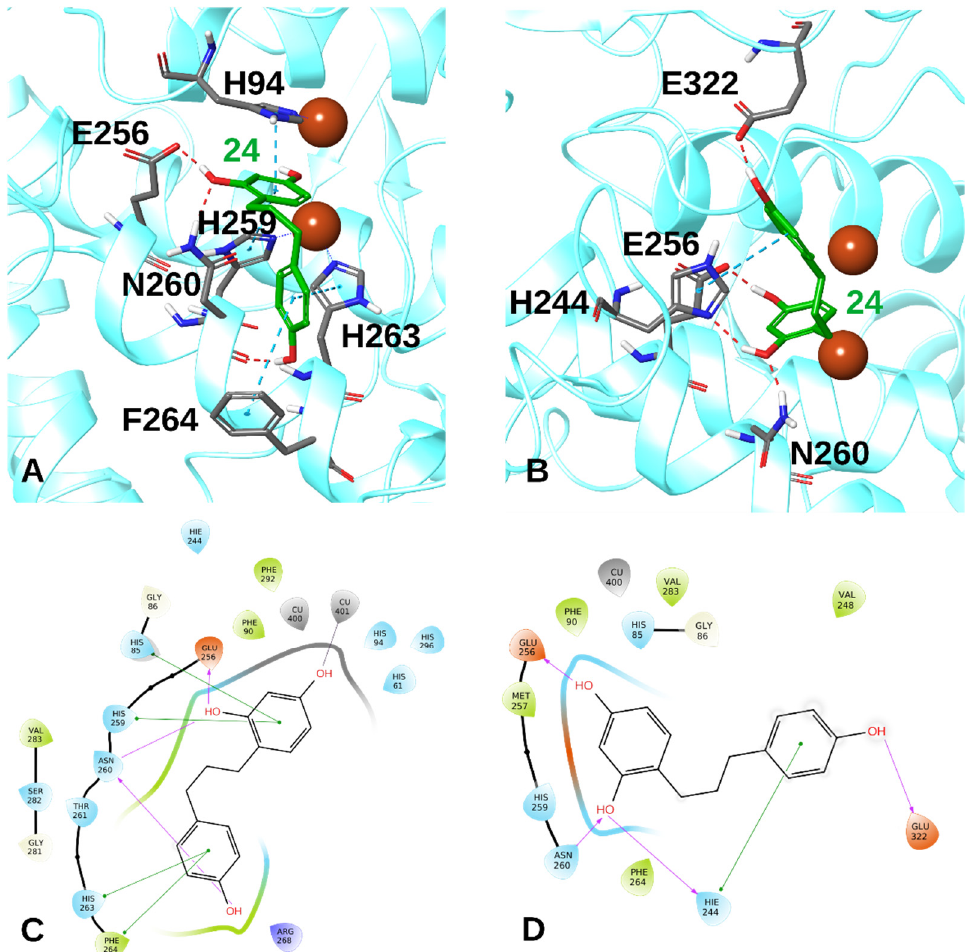
Figure 3. 2D and 3D representation of binding mode of compound 24 using the crystal structure of tyrosinase from Agaricus Bisporus . ( A , C ) Global minimum structure of Tyrosinase in complex with compound 24 . ( B , D ) Second minimum structure of tyrosinase in complex with compound 24 .